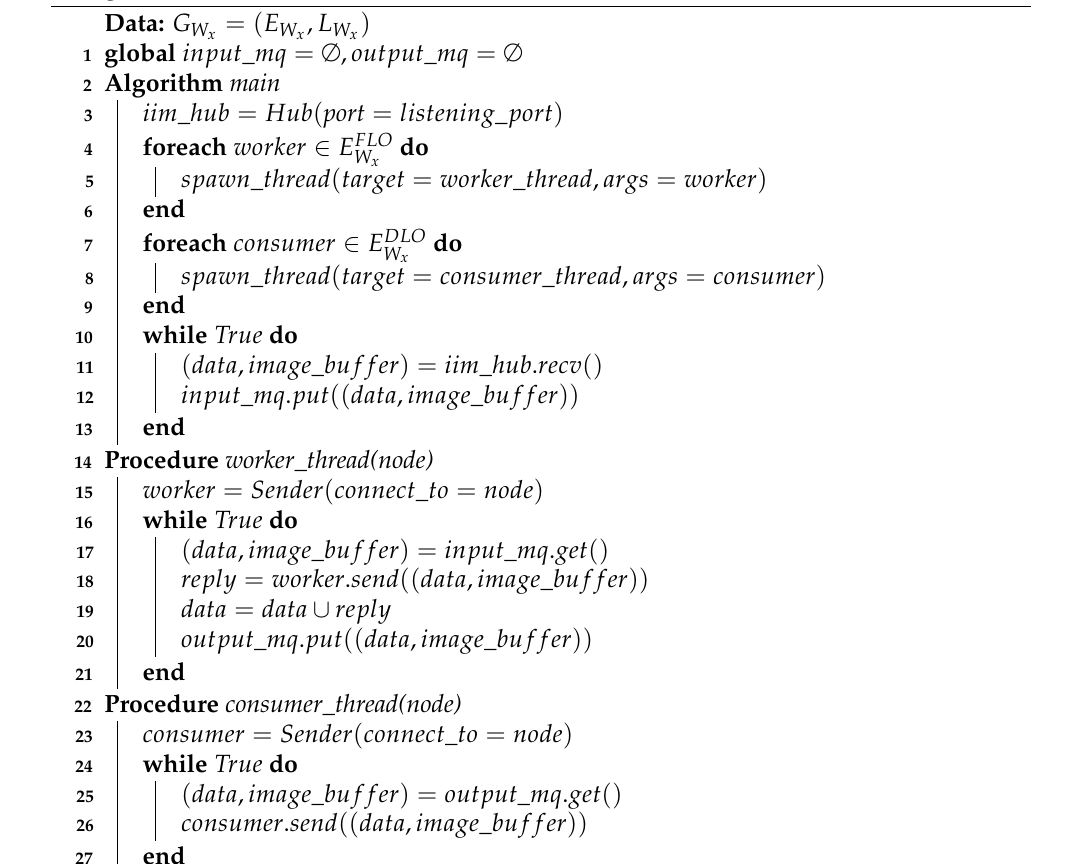
Algorithm 2: Broker’s load balance